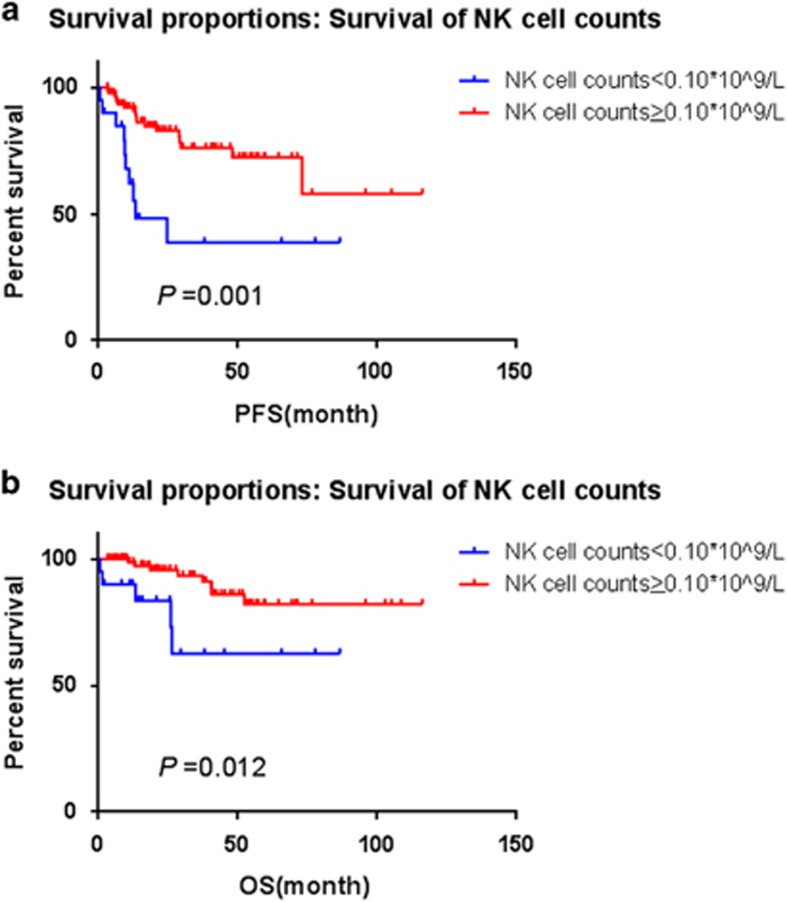
(a) Progression-free survival (PFS) of 114 patients with FL according to the absolute natural killer (NK) cell counts at presentation by Kaplan–Meier estimation. (b) Overall survival (OS) of 114 patients with FL according to the absolute natural killer (NK) cell counts at presentation by Kaplan–Meier estimation.